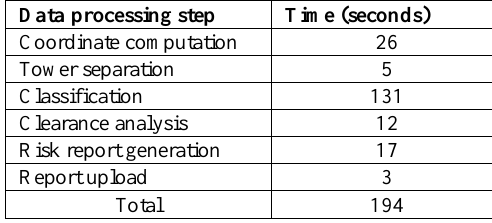
Table 3. Method efficiency evaluation